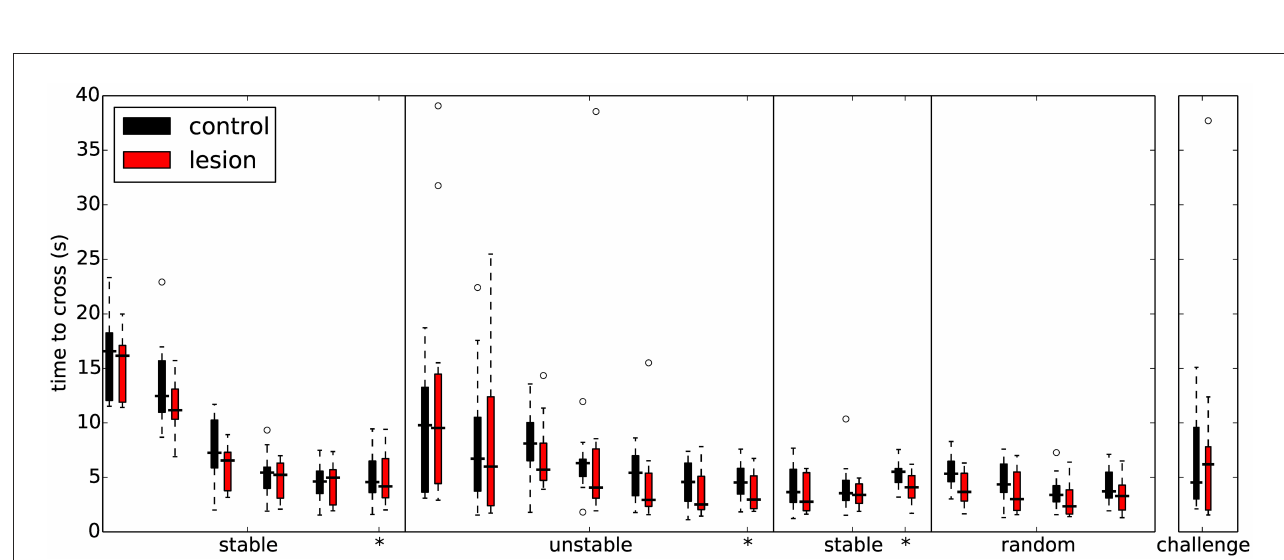
FIGURE4 Overall performance on the obstacle course is similar for both lesion ( n = 11) and control animals ( n = 11) across the different protocol stages. Each set of colored bars represents the distribution of average time to cross the obstacles on a single session. Asterisks indicate sessions where there was a change in assay conditions during the session (see text). In these transition sessions, the average performance on the 20 trials immediately preceding the change is shown to the left of the solid vertical line whereas the performance on the remainder of that session (after the change) is shown to the